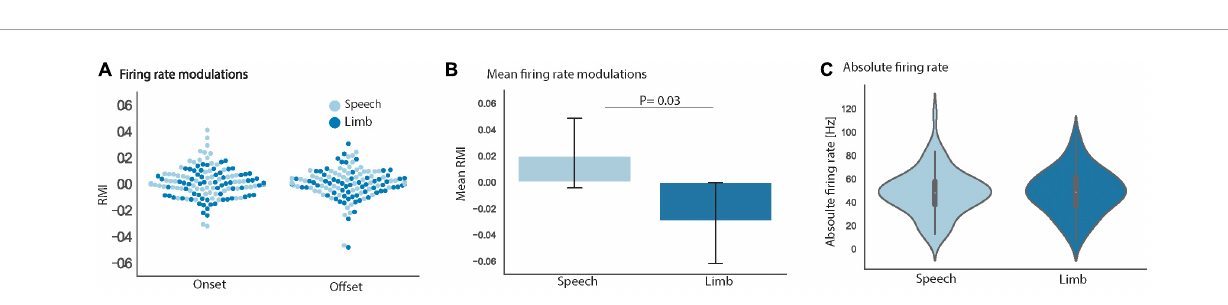
FIGURE4 (A) Mean RMI for all 69 units separately for the onset and offset alignments of speech (light blue) and limb movement (dark blue) did not differ. (B) Group mean RMIs for speech and limb movement tasks significantly differed [ t (201.40) = –2.18, p = 0.03] when onset and offset alignments were combined. (C) Group mean absolute firing rates for speech and limb movement did not significantly differ. The vertical lines display ± 1 standard error of the means. Data shown is from all 69 STN neuronal clusters in all